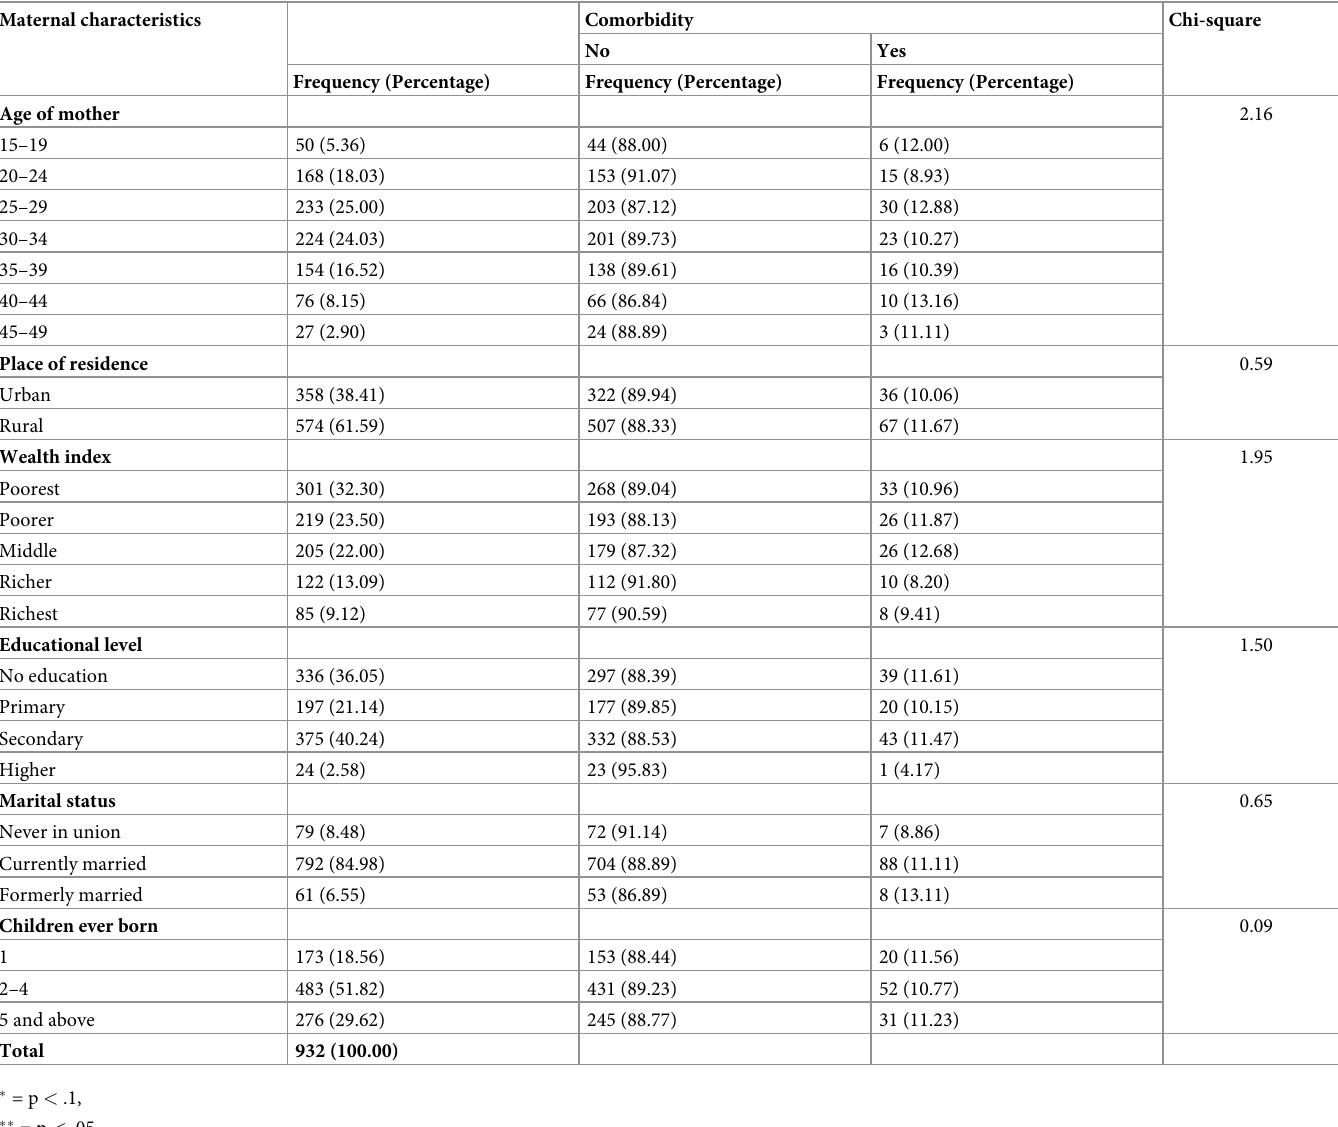
Table 1. Description of maternal